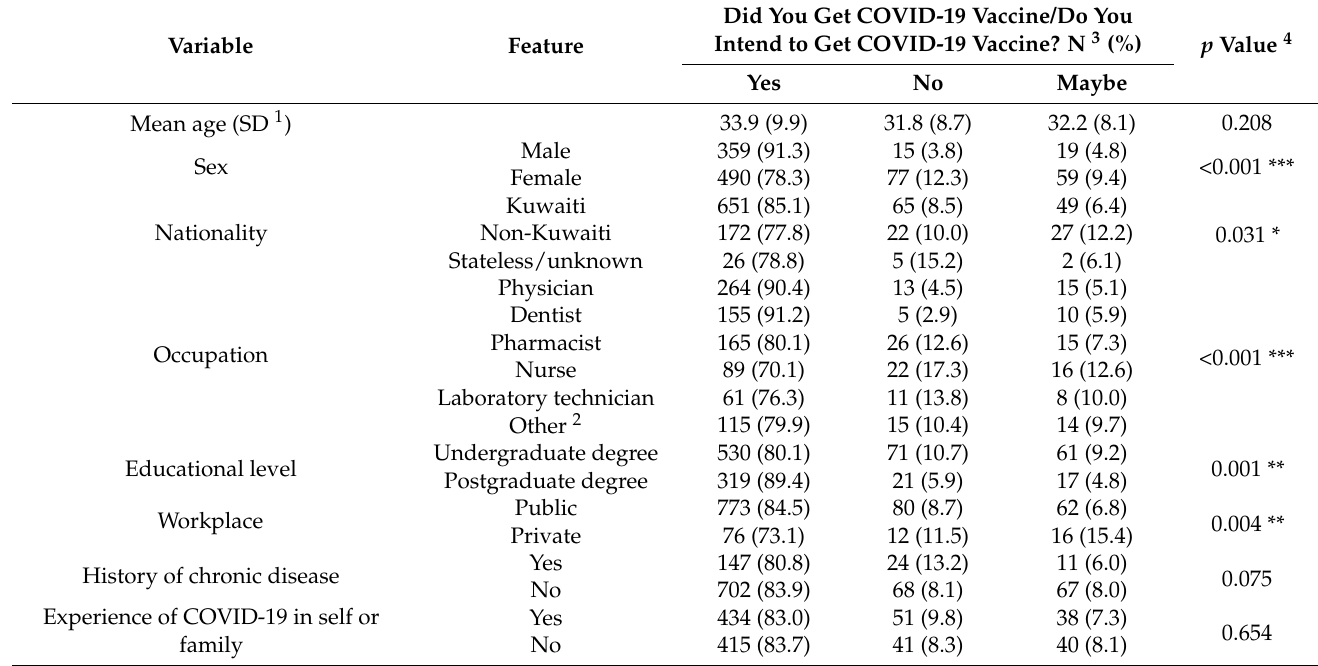
Table 3. Association of participants’ characteristics with intent to receive COVID-19